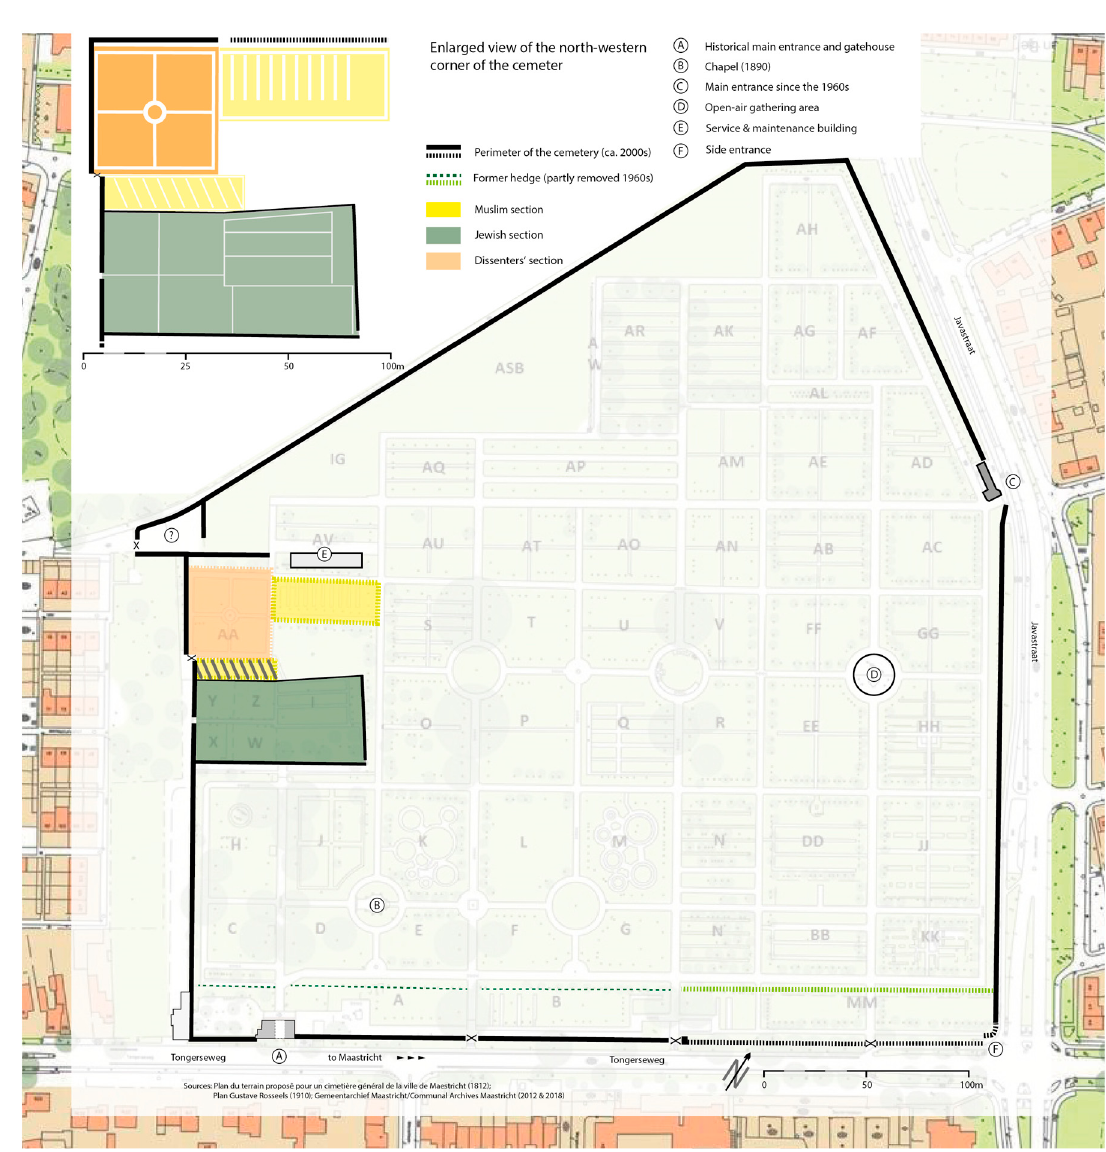
Figure 6. Schematic map indicating the Islamic sections (T.K.).